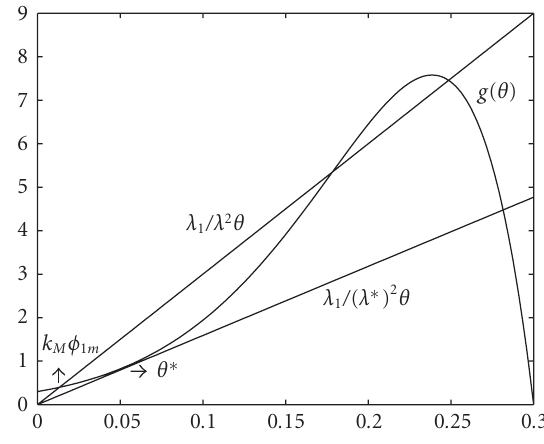
Figure 3.1. The values of θ ∗ and k M , for β = 0 . 3 and δ =